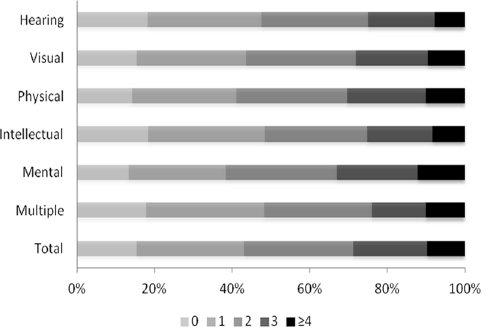
Fig 2. Number of risk factors among people with different disability